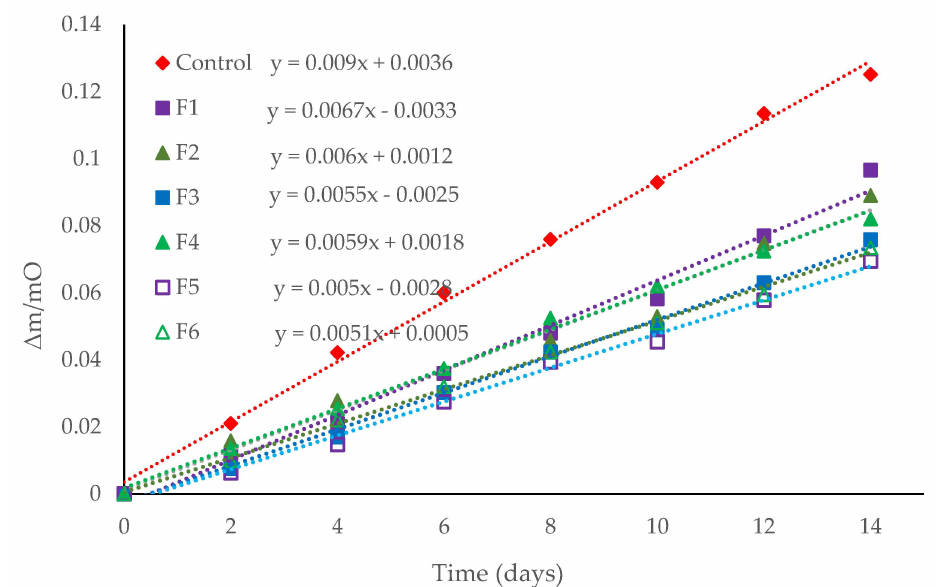
Figure 5. Weight loss of baby carrots with and without coating (F1, F2, F3, F4, F5, and F6), stored under 85% RH at 25 ◦ C for two